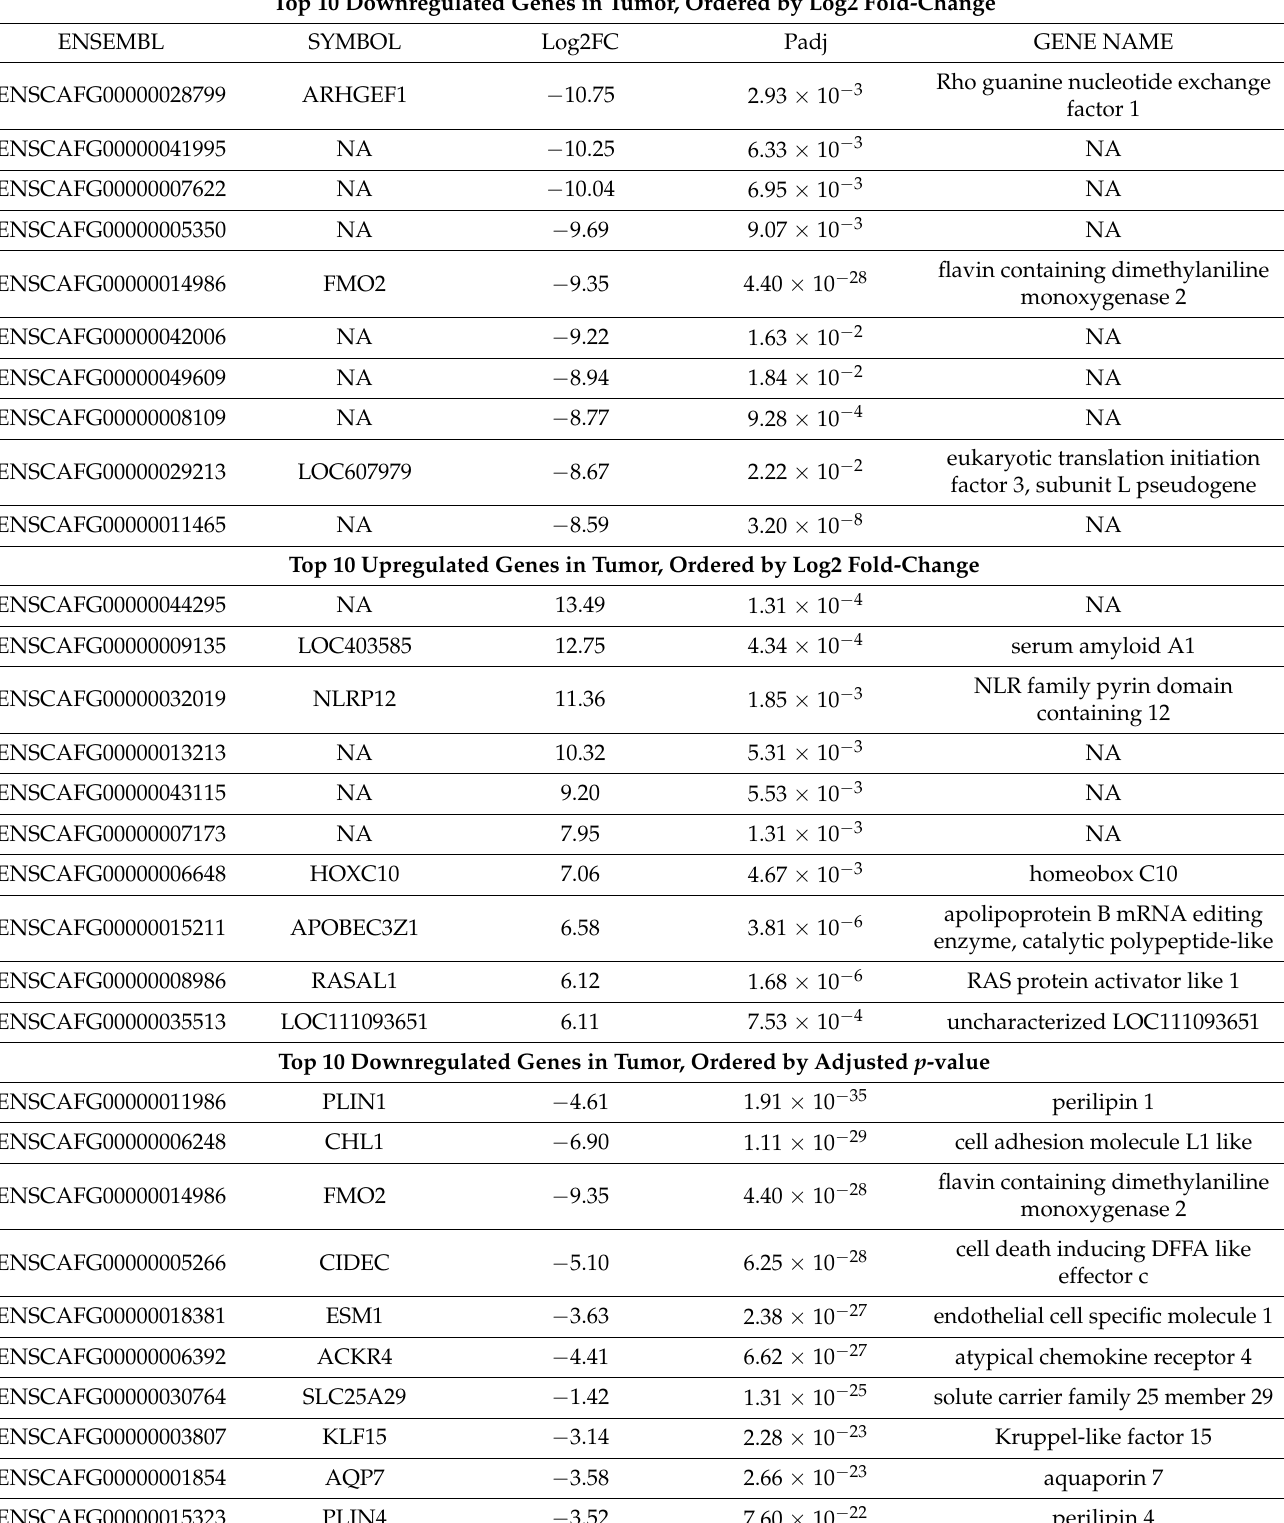
Table 2. List of top 10 upregulated and downregulated genes in tumor vs. normal from group analysis. When ordered by lowest and highest log2 fold-change, many of the ENSEMBL gene identifications do not correspond to known gene symbols. When ordered by smallest adjusted p -value (FDR), all ENSEMBL IDs correspond to known